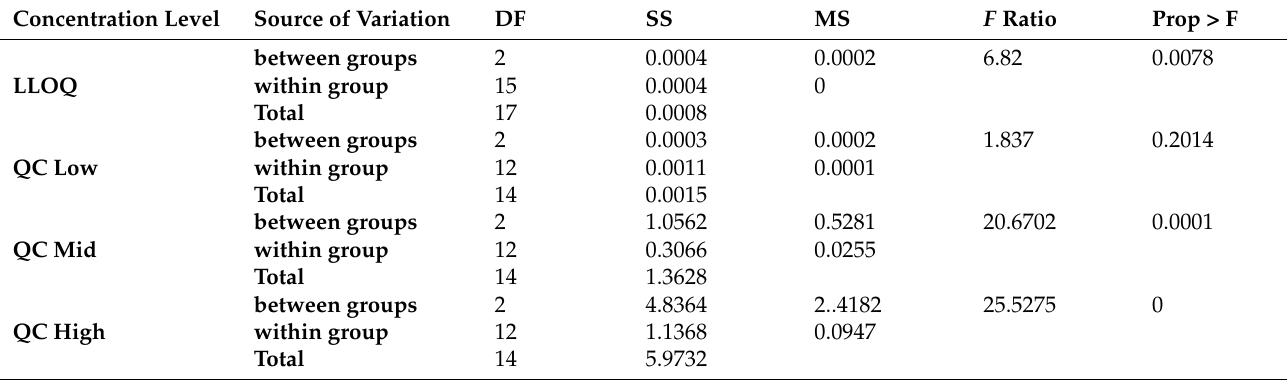
Table 4. Results of the ANOVA test for the intra- and inter-day accuracy and precision data. Concentration